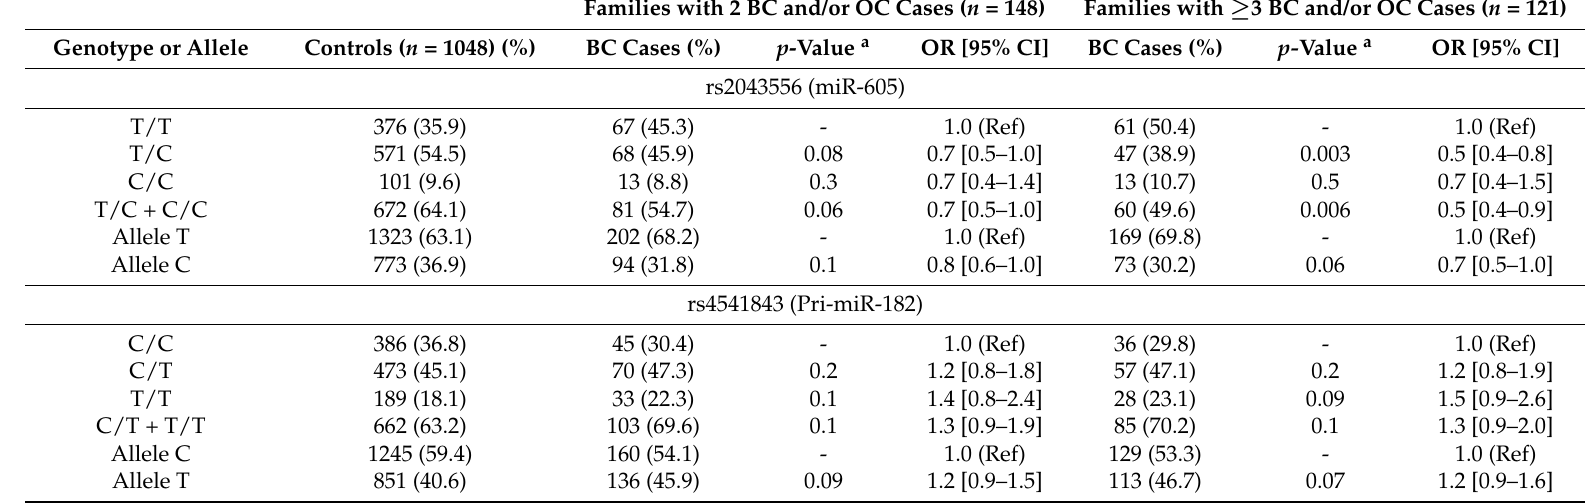
Table 3. Genotype and allelic frequencies of rs2043556 and rs4541843 according the number of BC cases in the families in BRCA1/2 -negative breast cancer cases and